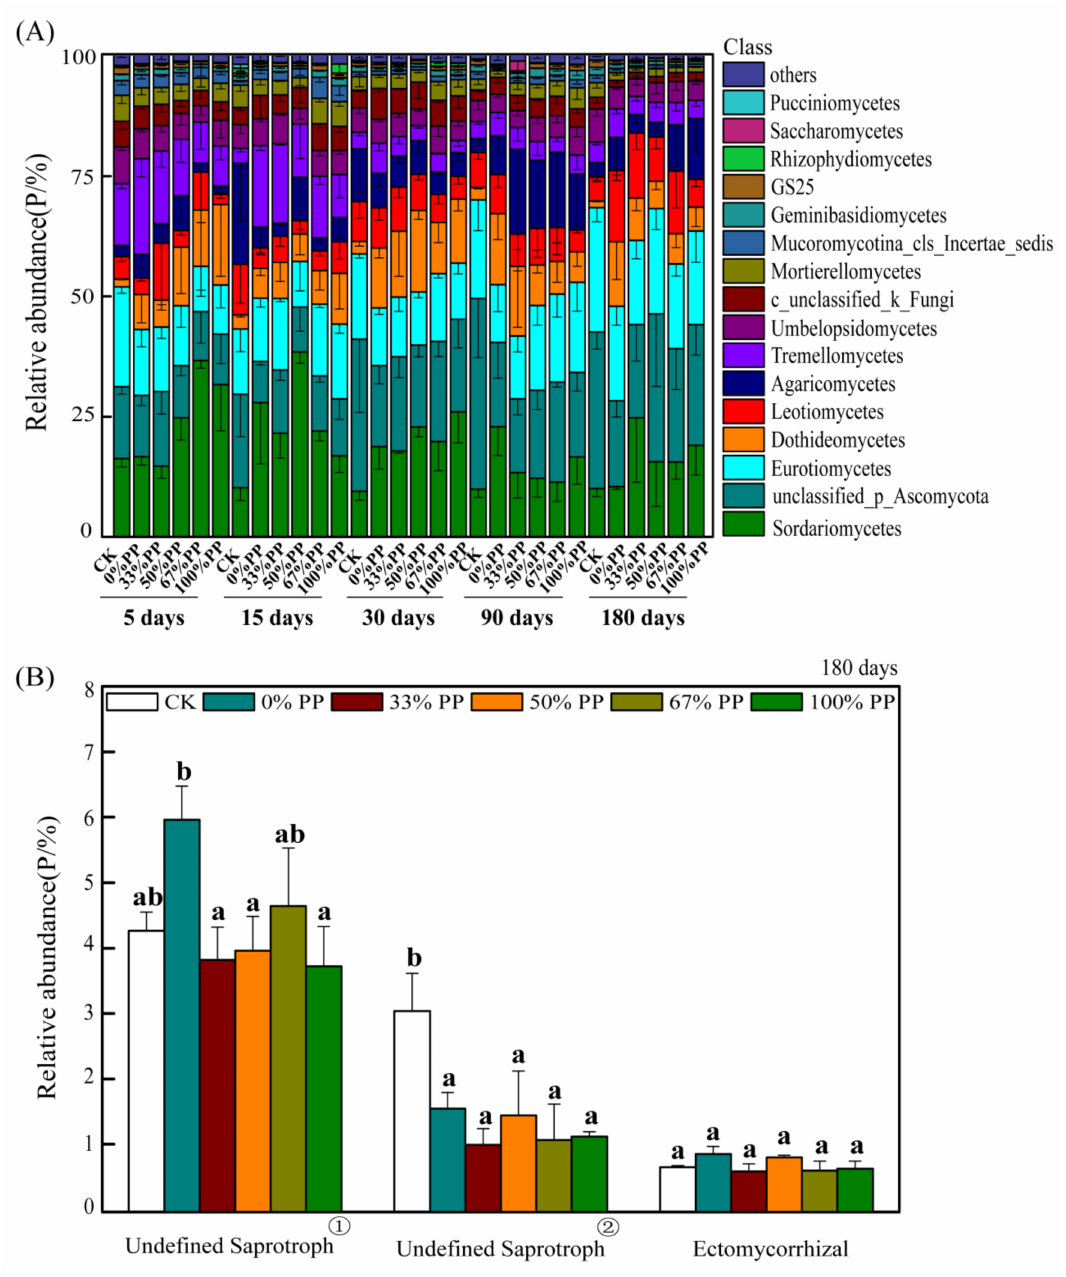
Figure 2. The community composition ( A ) and functional pathways ( B ) of the fungal community at the level of class in the broadleaved forest soil during incubation. Undefined Saprotroph ( 1 (cid:13) ): Fungal Parasite-Undefined Saprotroph; Undefined Saprotroph ( 2 (cid:13) ): Endophyte-Litter Saprotroph-Soil Saprotroph-Undefined Saprotroph. CK, with no litter; 0% PP, bamboo litter occupying at 0%; 33% PP, bamboo litter occupying at 33%; 50% PP, bamboo litter occupying at 50%; 67% PP, bamboo litter occupying at 67%; 100% PP, bamboo litter occupying at 100%. Error bars indicate standard deviation. Different letters show significant differences ( p <